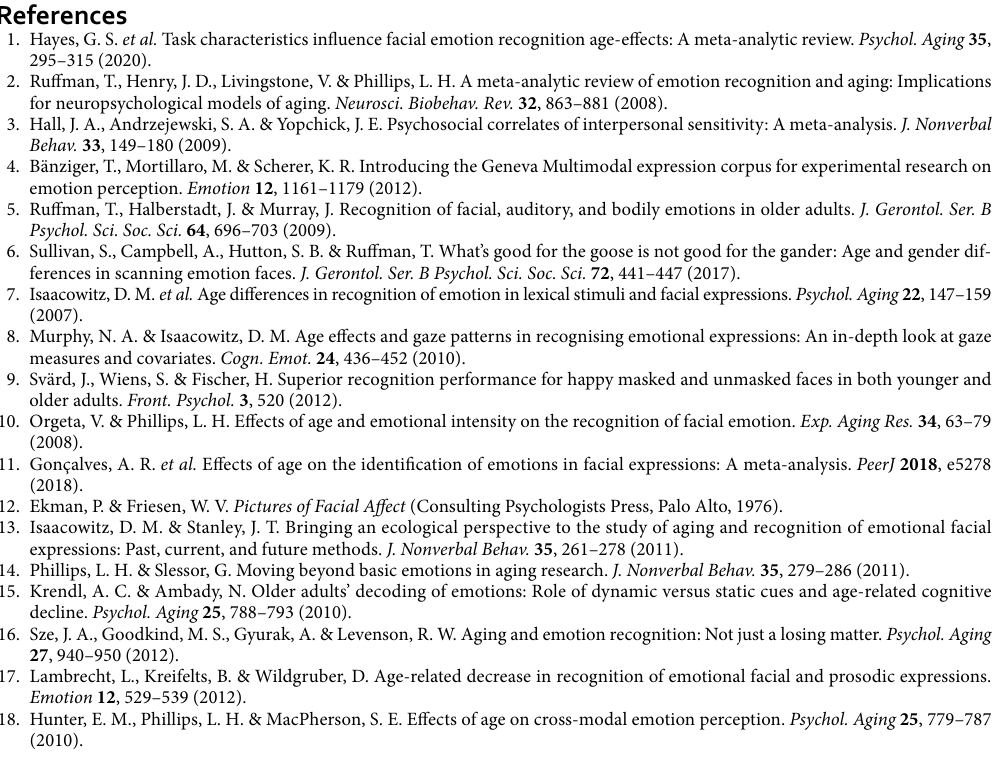
Table S7. Recognition rates for most emotions were positively correlated regardless of their valence, with happi- ness being the exception. Accuracy for happiness expressions was only significantly correlated with other positive expressions (i.e., interest pleasure, and